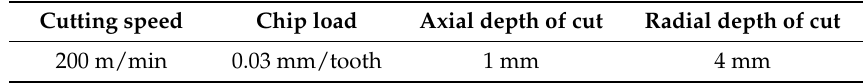
Table 1. Cutting parameters used for testing cutting tool rake angle and primary clearance